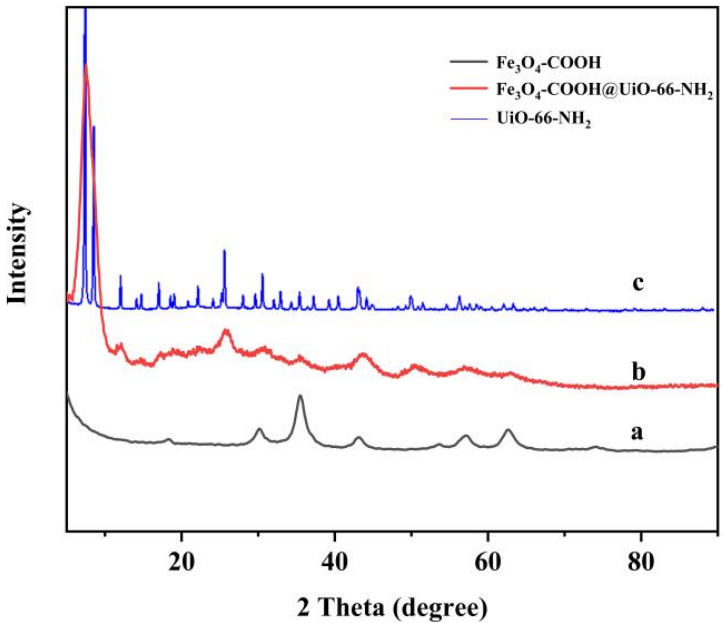
Figure 3. The XRD patterns of Fe 3 O 4 -COOH ( a ), Fe 3 O 4 -COOH@UiO-66-NH 2 ( b ), and UiO-66-NH 2 ( c ).